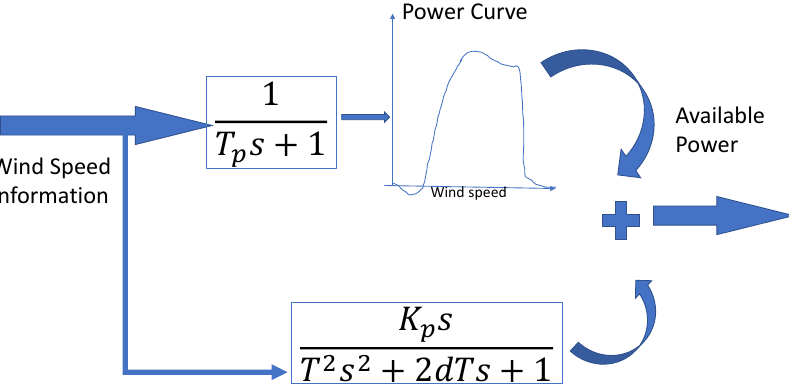
Figure 3. Schematic summary of the over-simplified model used for each sub-system in the windmill